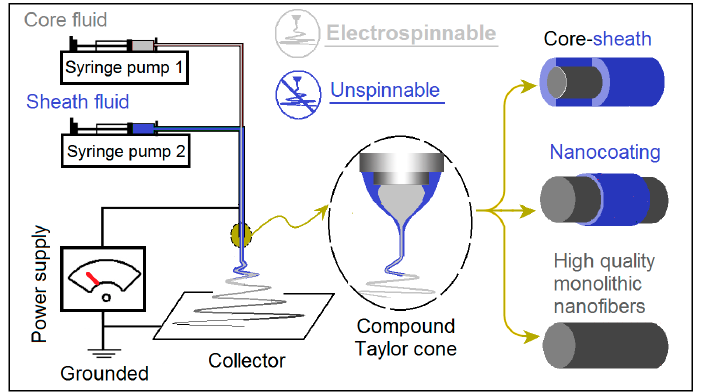
Figure 1. A diagram showing the modified coaxial electrospinning process, by which several different kinds of nanostructure can be created through manipulation of the unspinnable sheath fluid.